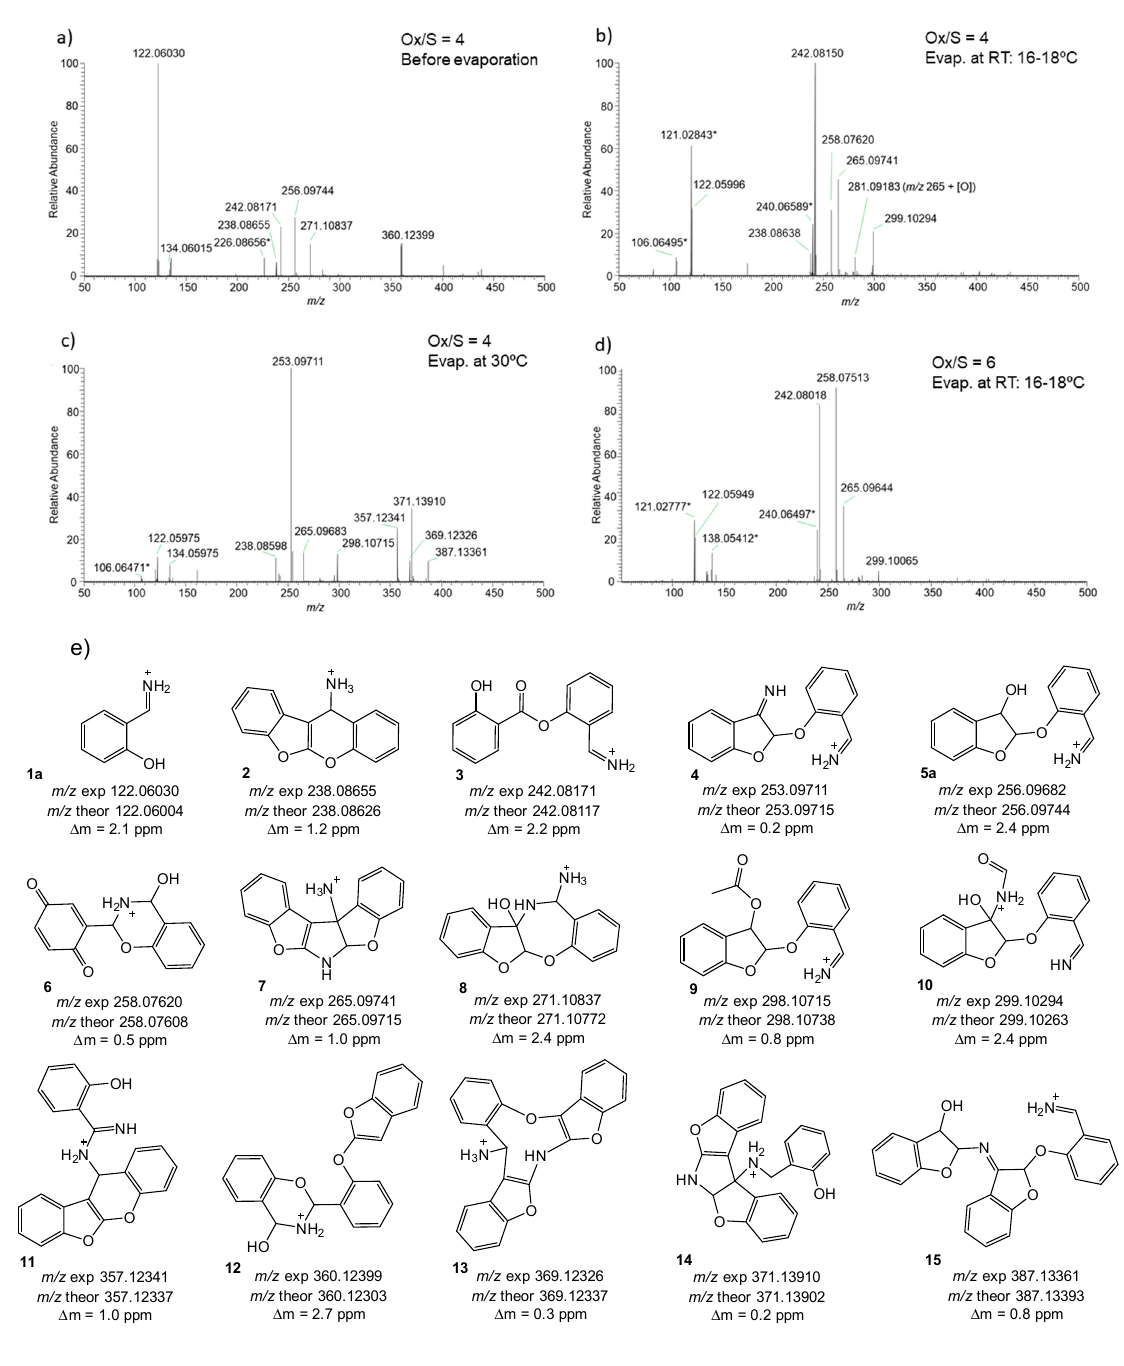
Figure 5. ( a – d ) Mass spectra of BF oxidation reaction mixtures in the presence of CAT I and NH 4 AcO, using Ox/S ratios of 4 or 6 and obtained before and after evaporation; ( e ) structure of mass ions identified during HRMS n analyses, in ascending order of m/z . The oxo forms of 1a and 5a were also characterized by NMR spectroscopy.